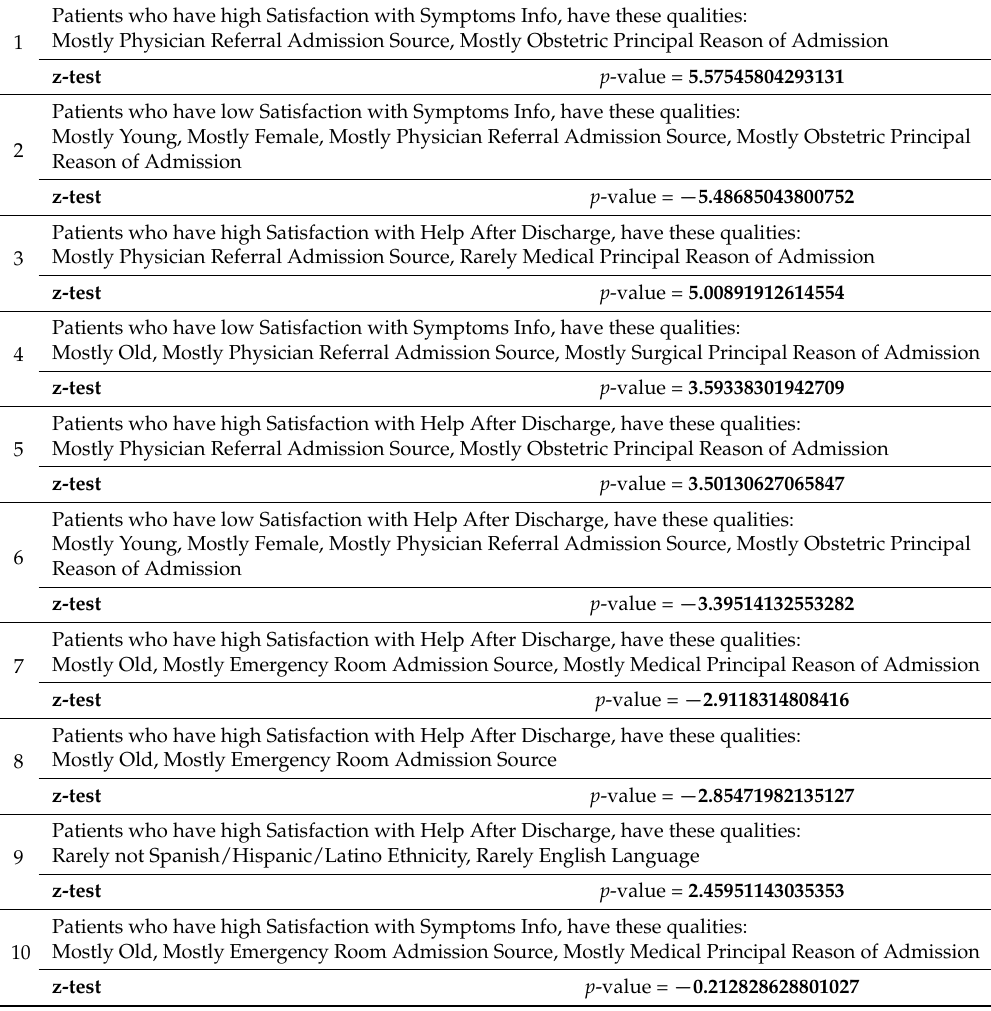
Table 16. The list of cleaned associations ranked based on their odds